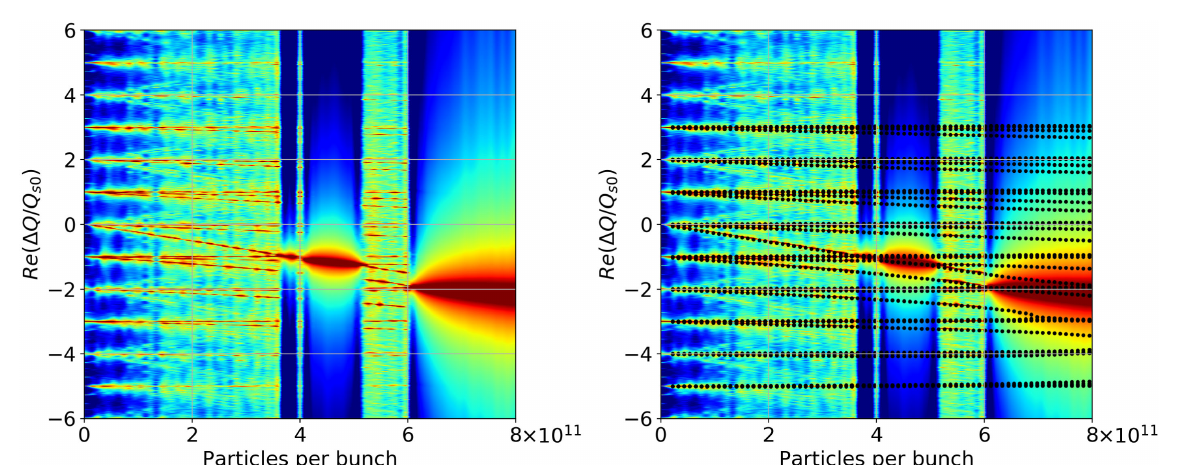
FIG. 14. Center of mass oscillations as a function of number of turns for an intensity of 6 . 8 × 10 11 particles per bunch with the corresponding exponential fit (red curve).